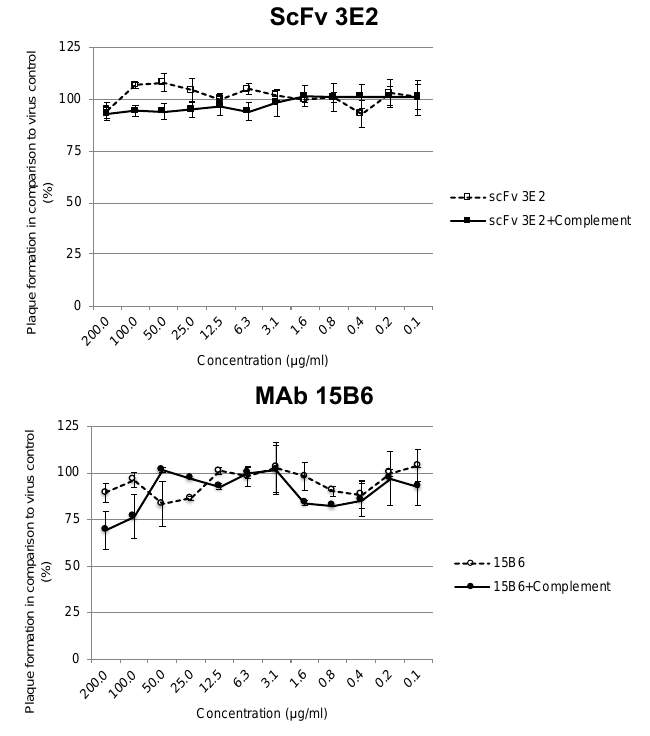
Figure 9. In vitro Plaque Reduction Neutralisation Test. The scFv 3E2 ( A ) and the mAb 15B6 ( B ) with and without complement did not neutralise the VACV Elstree.